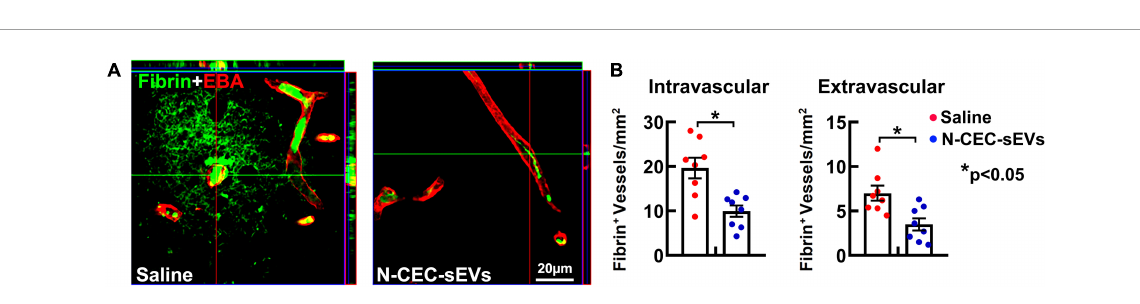
indicating that impairment of endothelial cell permeability by DM-CEC-sEVs is